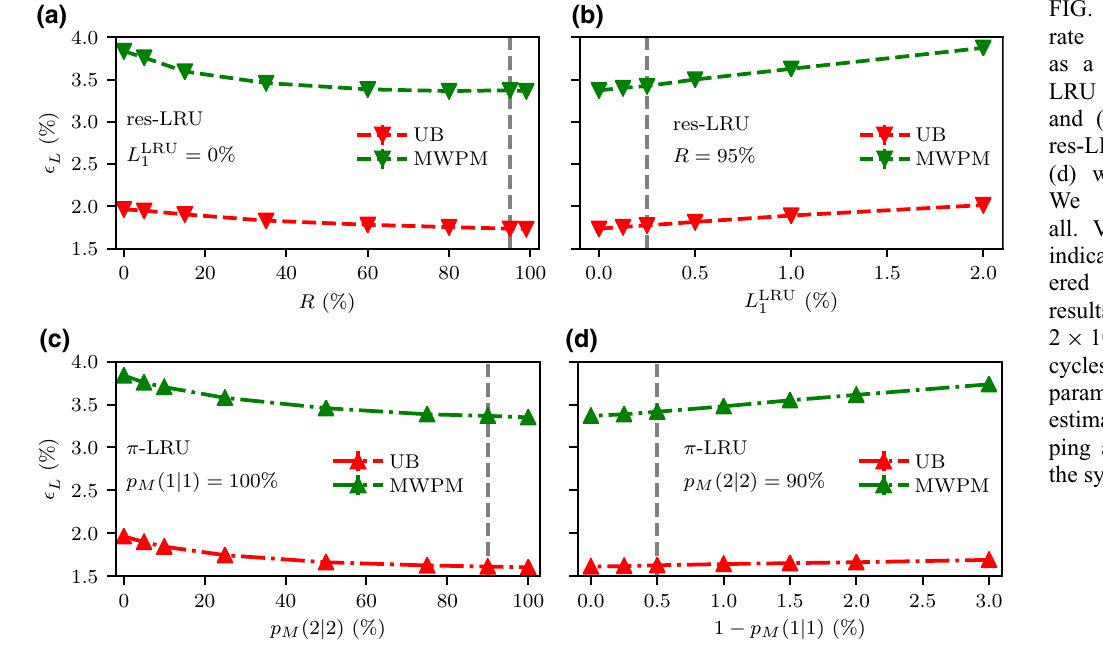
FIG. 9. Logical error rate ε L per QEC cycle as a function of various LRU parameters. In (a) and (b) we use only the res-LRU, while in (c) and (d) we use the π -LRU. We fix L 1 = 0.5% for all. Vertical dashed lines indicate the values consid- ered in Sec. II D. These results are extracted from 2 × 10 4 runs of 20 QEC cycles each per choice of parameters. Error bars are estimated using bootstrap- ping and are smaller than UB the symbol MWPM